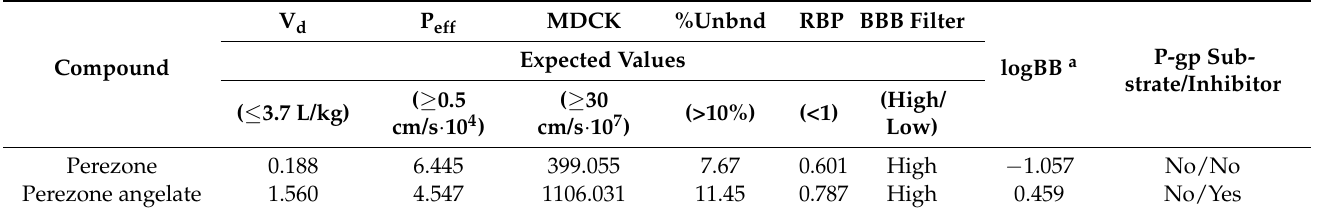
Table 2. Theoretical values of distribution V d , effective permeability P eff , apparent